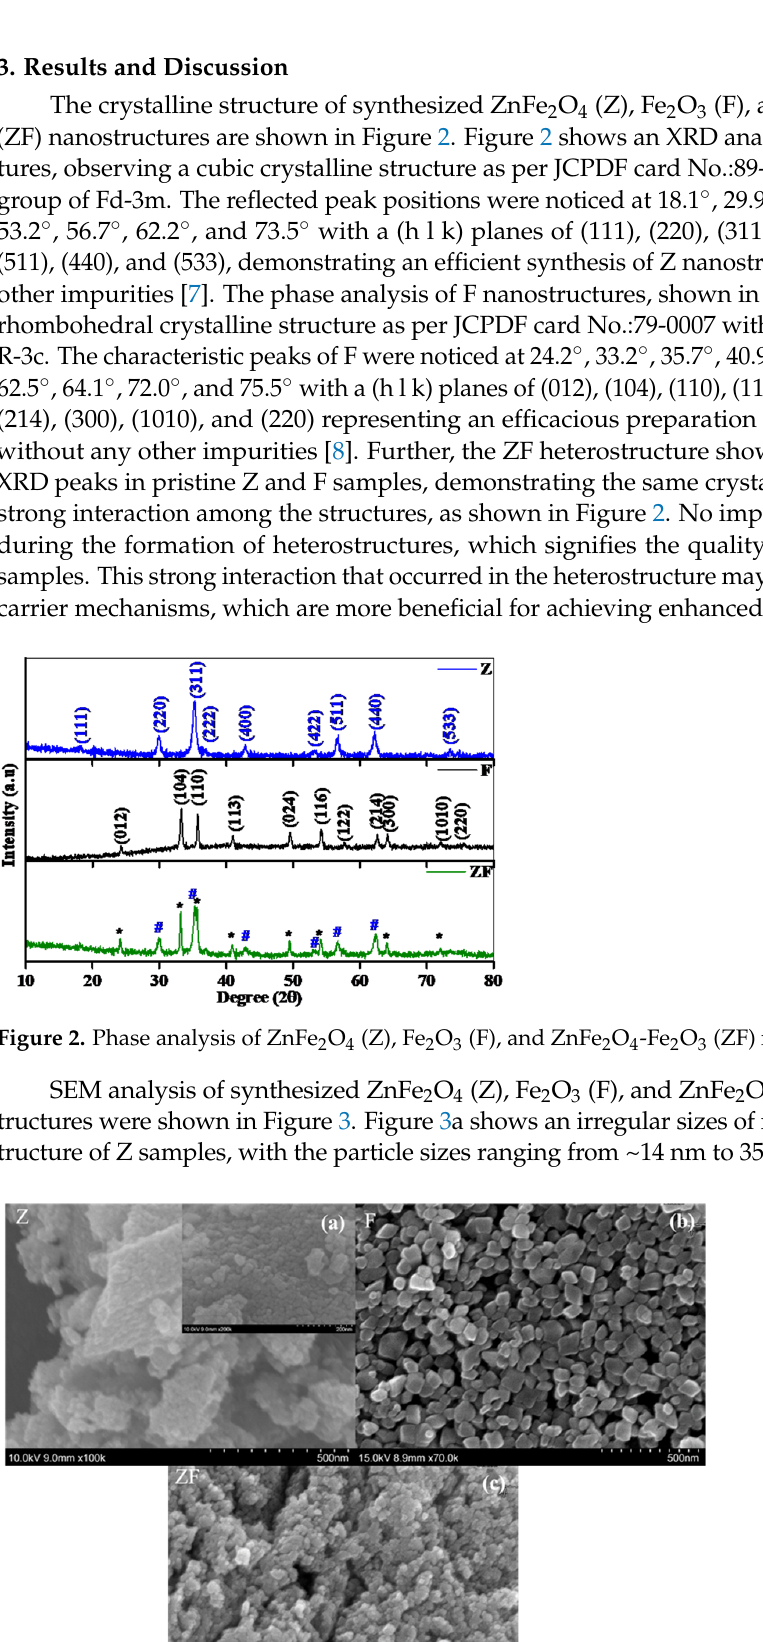
Figure 3. Morphology images of ( a ) ZnFe 2 O 4 (Z), ( b ) Fe 2 O 3 (F), and ( c ) ZnFe 2 O 4 -Fe 2 O 3 (ZF) nanostruc- tures.